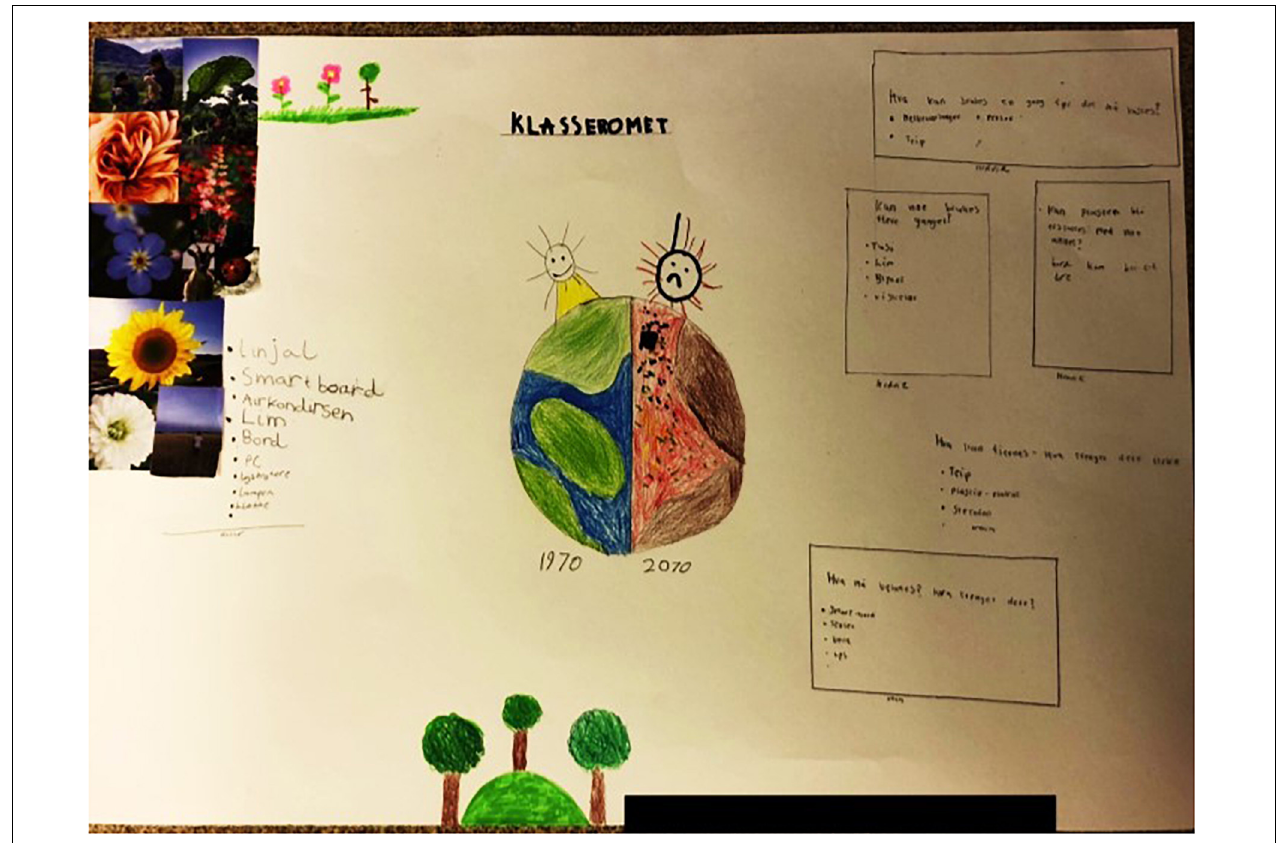
FIGURE 8 | Creative engagement within the frame “classroom” illustrating, amongst other things, a drawing of a destroyed future